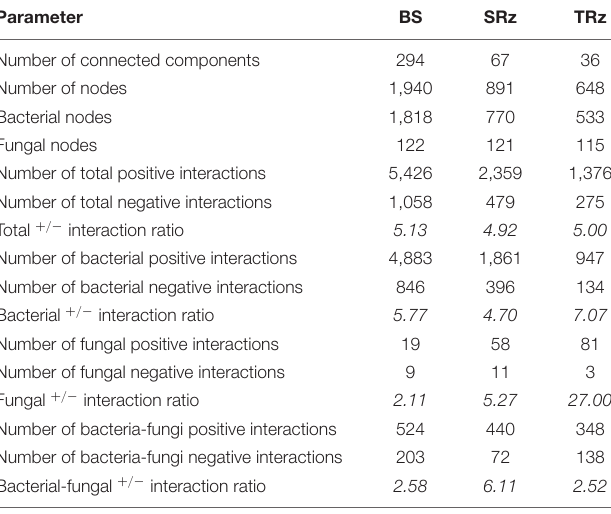
TABLE 1 | Parameters of microbial interaction